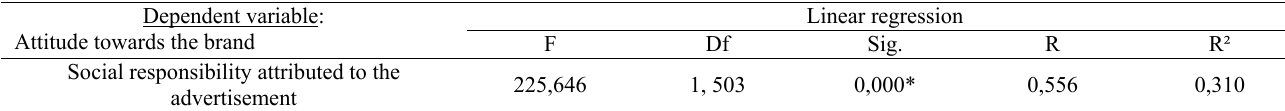
Table 4: Hypothesis HO 5 – Linear